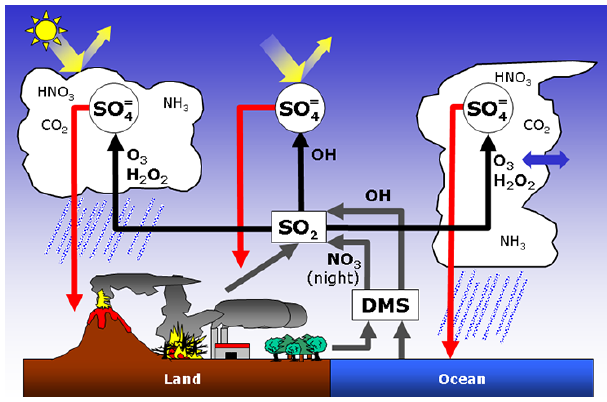
Figure 1. Schematic representation of the sulfur cycle and radia- tive effects of sulfate aerosols in CanAM4.1. In each grid cell, the model accounts for sources and sinks of sulfate aerosol (SO 2 − SO 2 , and DMS. SO 2 is emitted from volcanos, fires, and anthro- pogenic sources. DMS is mainly emitted from the oceans, but there are also some terrestrial sources. DMS is oxidized to SO 2 by OH during the day and by NO 3 during the night. SO 2 is oxidized to sulfate both within clouds and under clear-sky conditions. In-cloud oxidation of sulfur and wet deposition is treated separately for layer (stratiform) and convective clouds. For both types of clouds, oxi- dation occurs via ozone (O 3 ) and hydrogen peroxide (H 2 O 2 ). Ox- idation rates depend on the pH of the cloud water, which depends on the concentrations of nitric acid (HNO 3 ), ammonia (NH 3 ), and carbon dioxide (CO 2